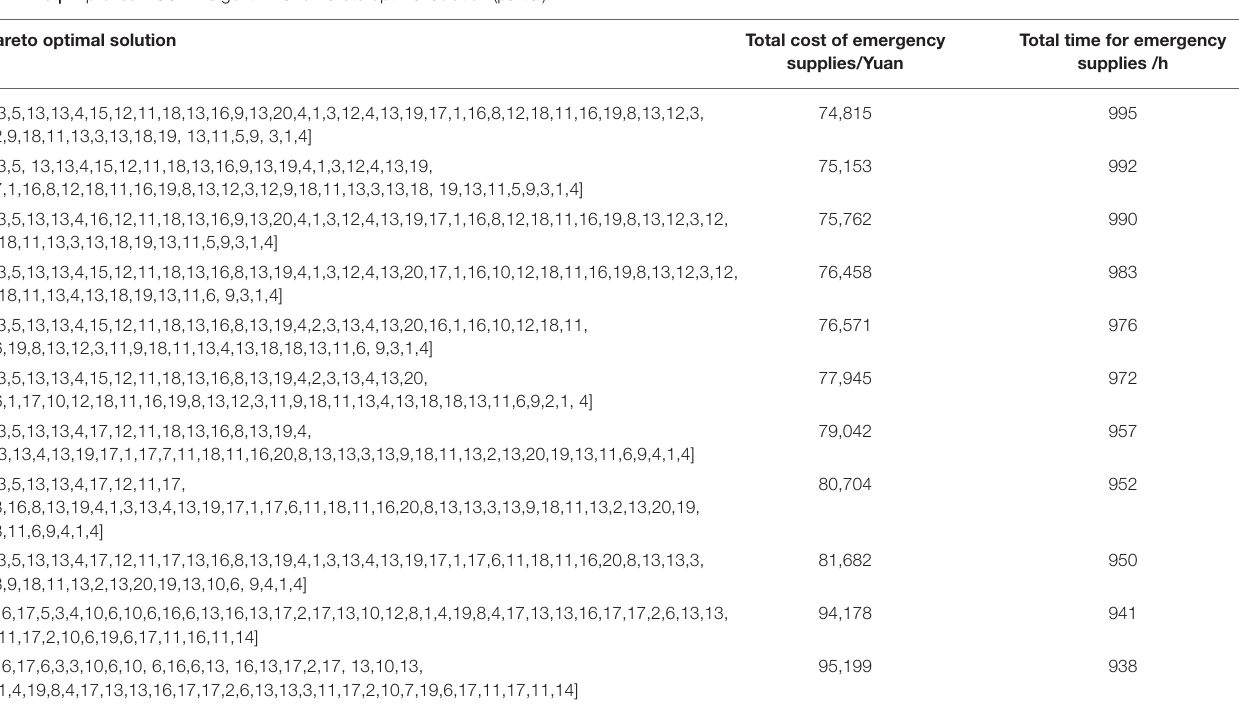
TABLE 6 | Improved NSGA-II algorithm and Pareto optimal solution (partial). Pareto optimal